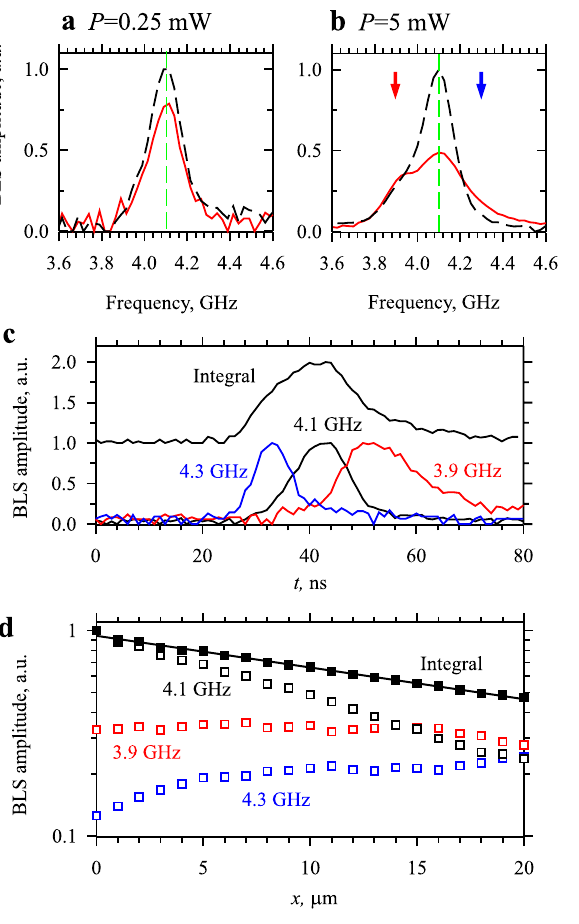
Figure 5. Analysis of SPM in the frequency and spatial domains. ( a ) and ( b ) Frequency spectra of the spin- wave pulses measured at P = 0.25 and 5 mW, respectively. Dashed curves show the spectra recorded at x = 0, while solid curves show the spectra obtained at x = 10 µm. Vertical dashed lines mark the carrier frequency 4.1 GHz. Arrows in ( b ) mark the frequencies of the analyzed side components. ( c ) Normalized temporal profiles of the amplitude envelope A ( t ) for the spectral components at the specified frequencies. The profile obtained by integration over the entire frequency spectrum is shown for reference. This profile is shifted by 1 a.u. for clarity. ( d ) Spatial dependences of the amplitude of the main component at 4.1 GHz, side components at 3.9 and 4.3 GHz, as well as the dependence of the total signal integrated over the entire frequency spectrum. Symbols− experimental data. Solid curve−exponential